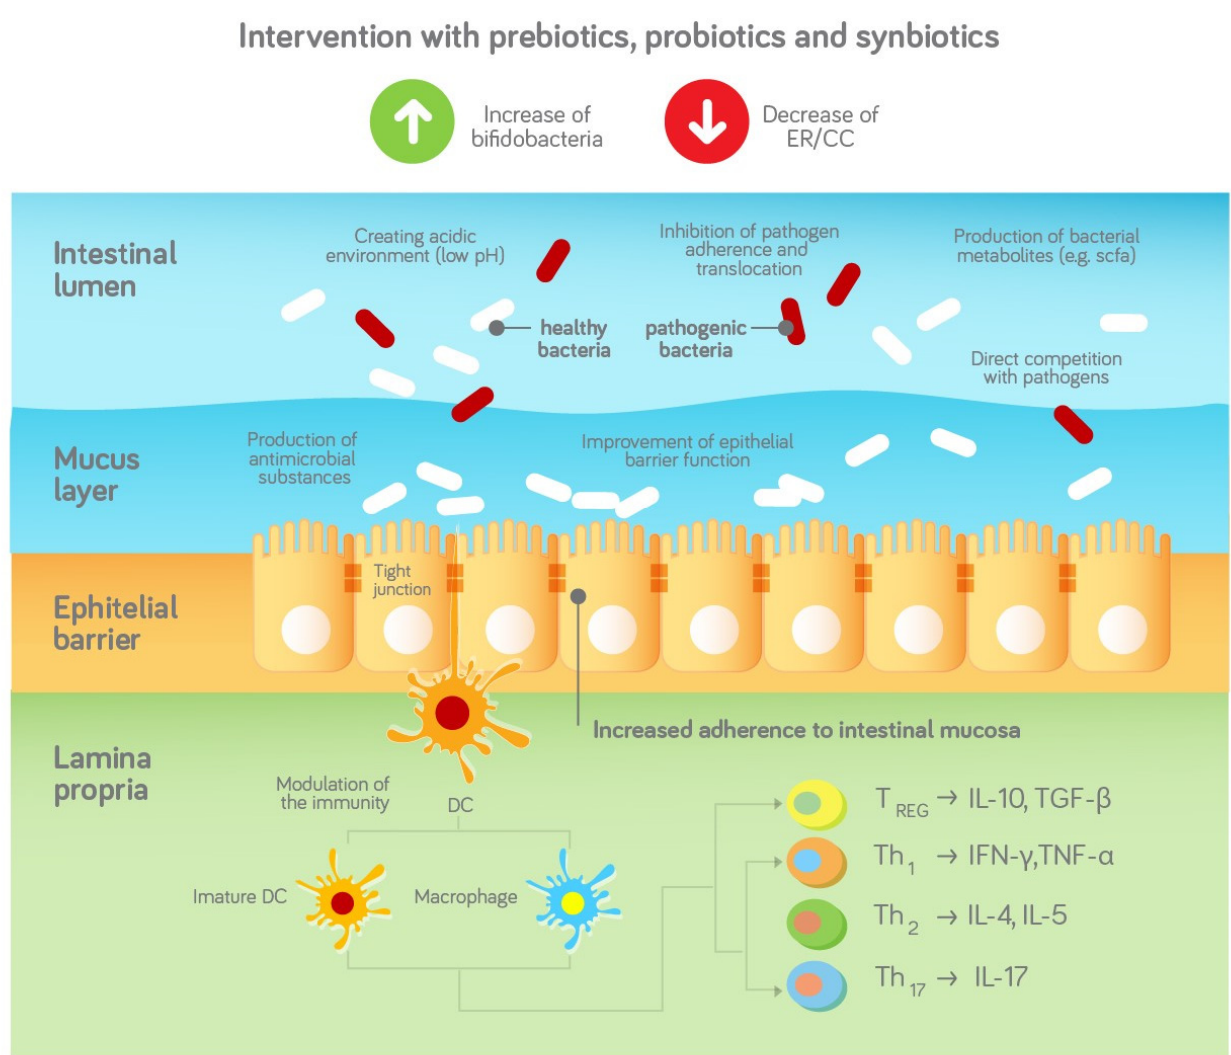
Figure 1. Schematic representation of the effects of prebiotics, probiotics and synbiotics on the gut microbiota and infection outcomes based and adapted from [37], with permission .